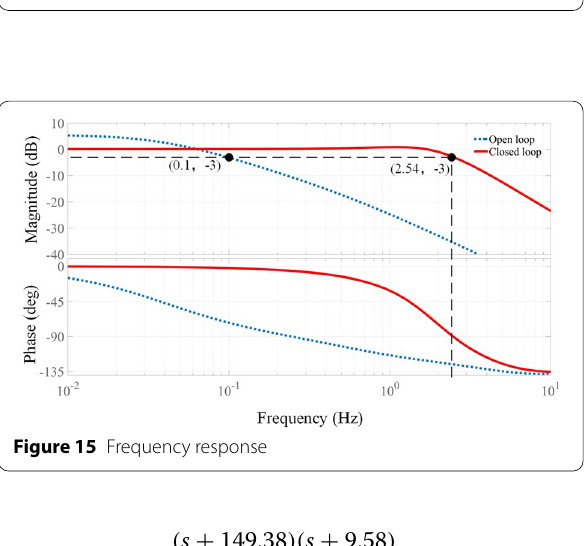
Figure 14 Model validation